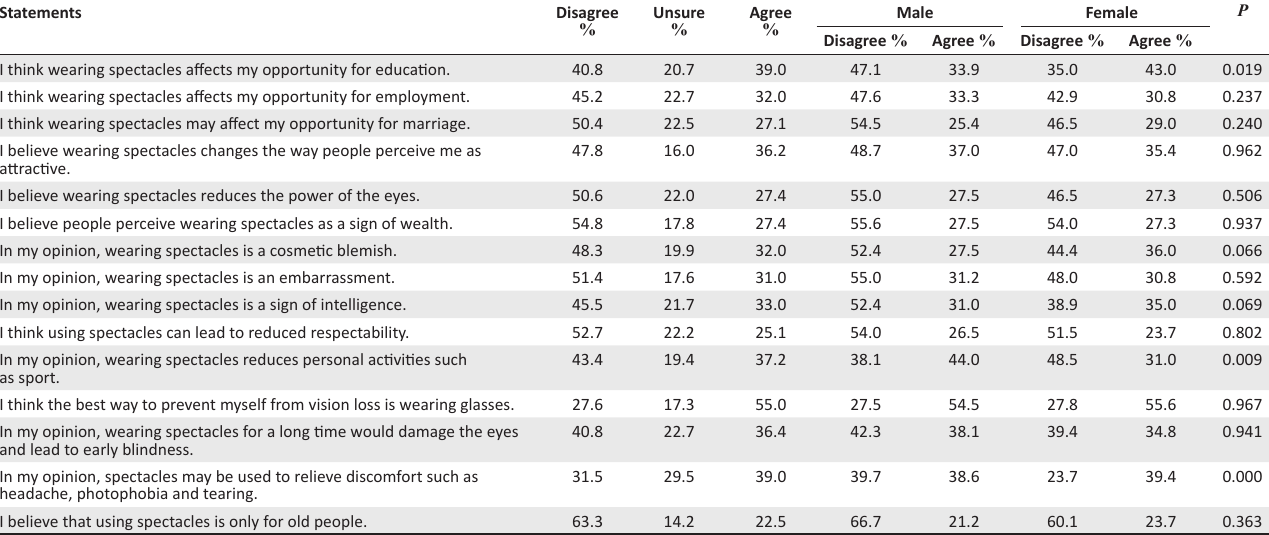
TABLE 2: Attitudes and perceptions of the 387 students towards spectacle wear and eye care.